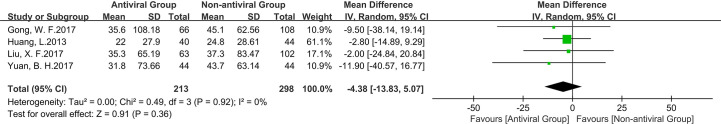
The Forest plot to compare the effect of anti-viral treatment vs. no treatment in liver function.